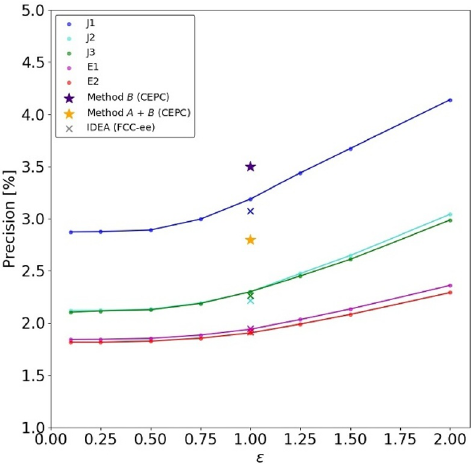
Figure 20 . Expected precisions of measuring (cid:0) h versus detector energy/momentum resolution. " = 1 : 0 corresponds to the baseline resolution de(cid:12)ned by the CEPC detector template [73]. The purple and orange stars represent the precisions expected to be achieved with 5.6ab (cid:0) 1 data at CEPC 240 , using Method B and A+B, respectively [17, 19]. The colored crosses denote the precisions achieved by applying J1, J2, J3, E1 and E2 classi(cid:12)ers to the FCC-ee IDEA data at 240GeV. For